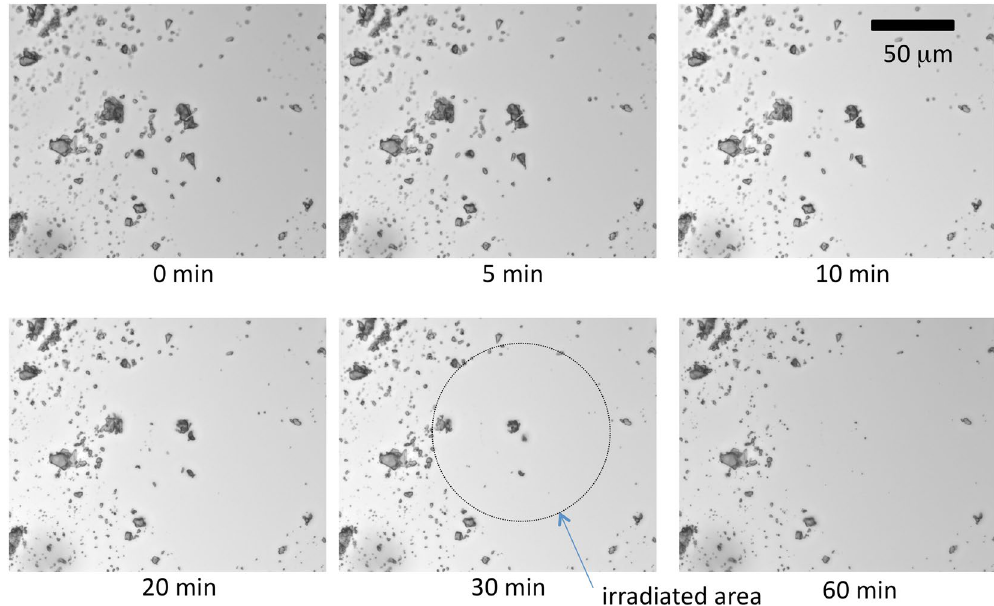
Figure 4. Bright-field microscopy images of crystals of 3 in water before and after UV irradiation (330–385 nm, 290 mW/cm 2 ) for 5, 10, 20, 30 and 60 min at room temperature. The region between the slide glass and cover glass of the sample shown in Fig. S8 was filled with water before this